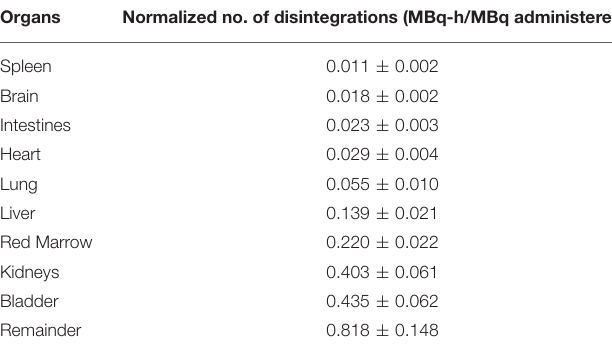
TABLE 2 | Normalized number of disintegrations of source organs for macaque monkey injected with 64 Cu-BaBaSar-RGD 2 . Organs Normalized no. of disintegrations (MBq-h/MBq administered)